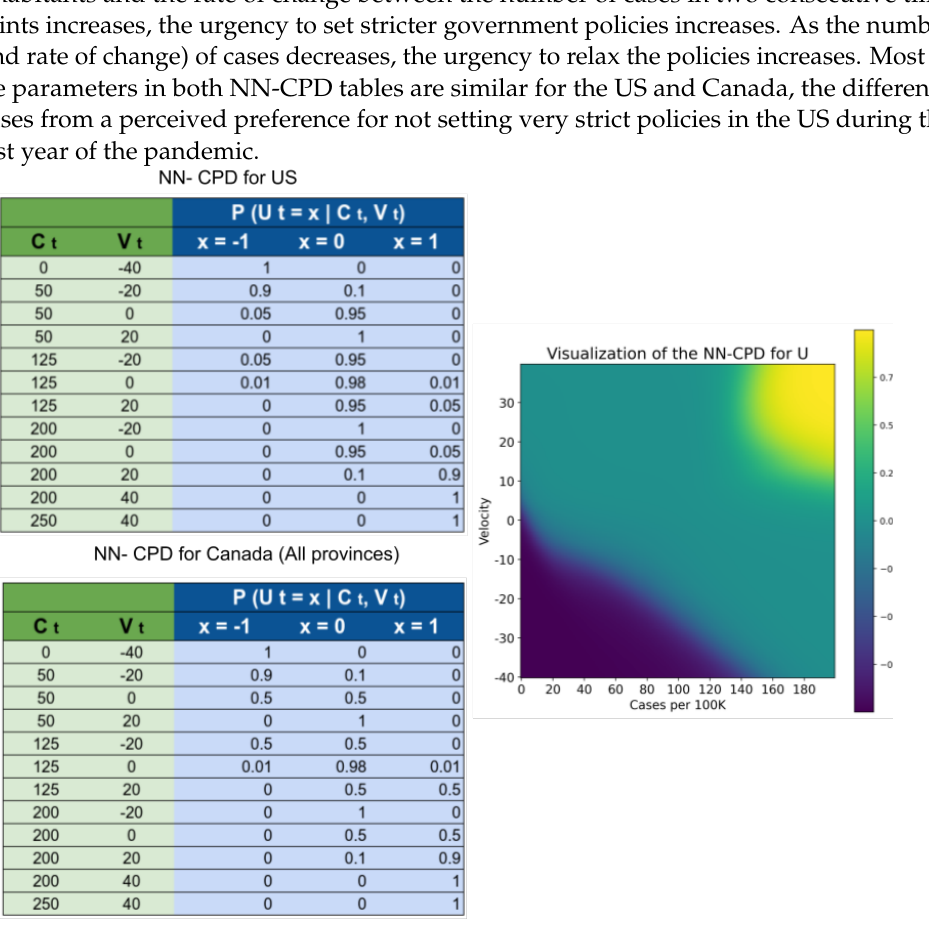
Figure 5. Dataset used to create the NN-CPD for the variable U t and its visualization. Values closer to 1 (yellow) increase p ( U t = 1 | C t , V t ) . Values closer to 0 (green) increase p ( U t = 0 | C t , V t ) . Values closer to − 1 (blue) increase p ( U t = − 1 | C t , V t )